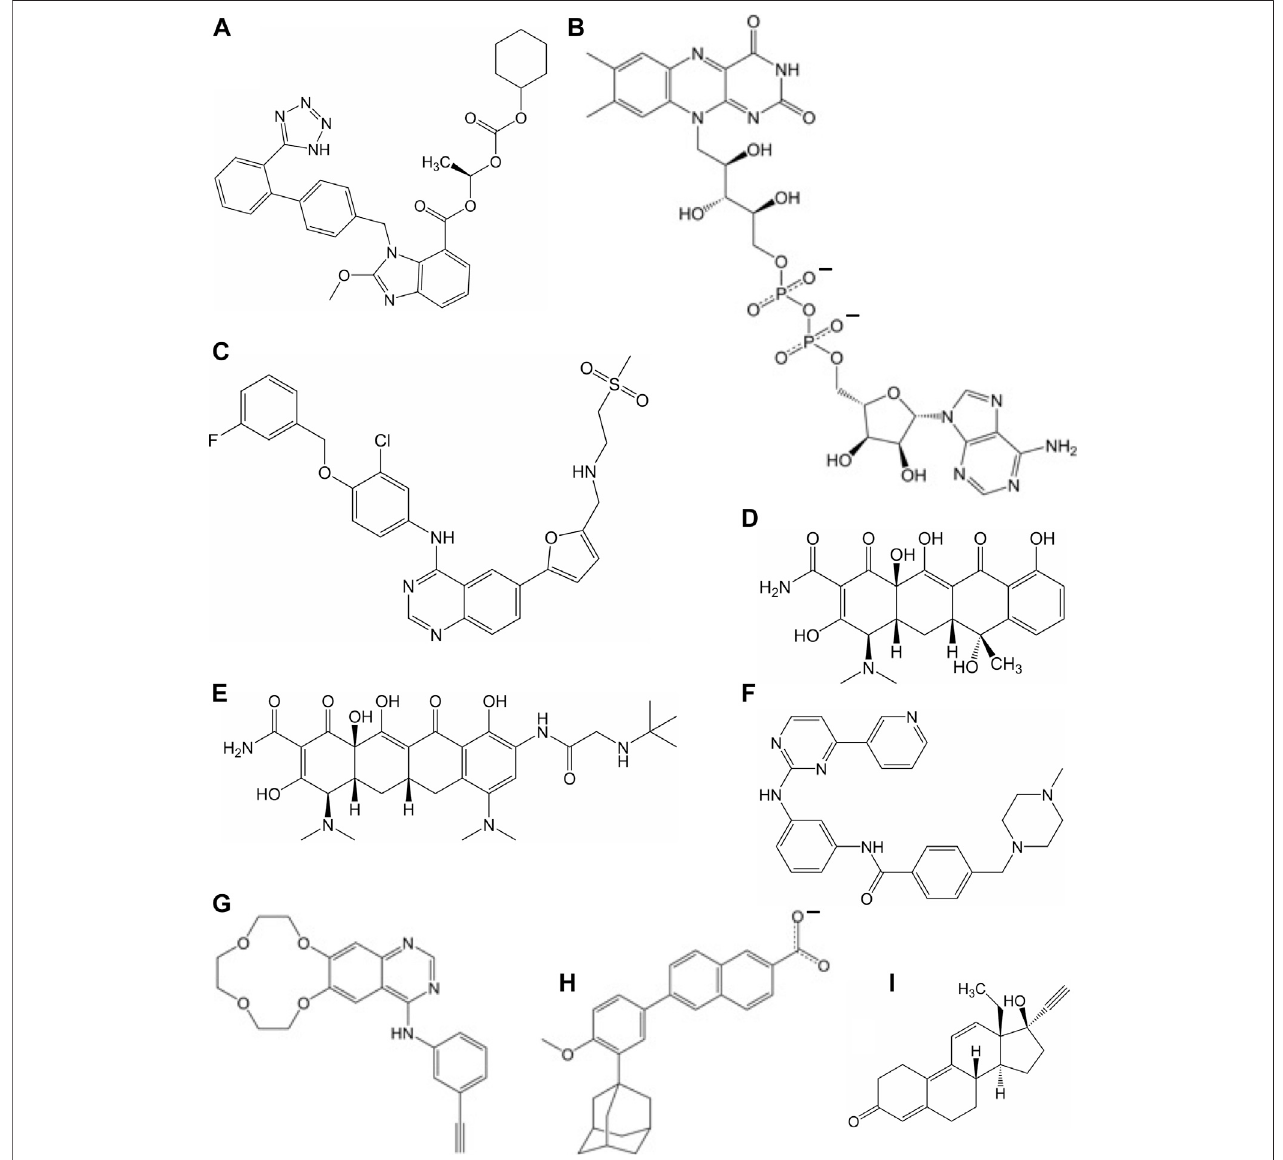
FIGURE 3 | Molecular of structures for compounds that have a repressive effect on some aspect of the virus activity: (A) candesartan cilexetil, (B) fl avin adenosine dinucleotide, (C) lapatinib, (D) tetracycline, (E) tigecycline, (F) imatinib, (G) icotinib, (H) adapalene, and (I) gestrinone.